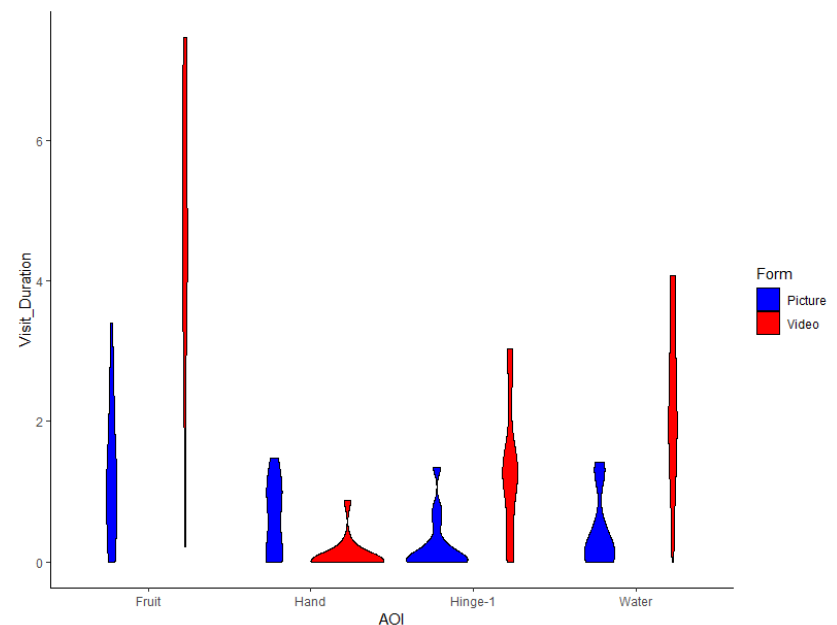
Figure 5. Violin plots highlighting the most significant differences on Total Visit Duration (TVD) Diff% between forms of representation for the product Equilibrium.